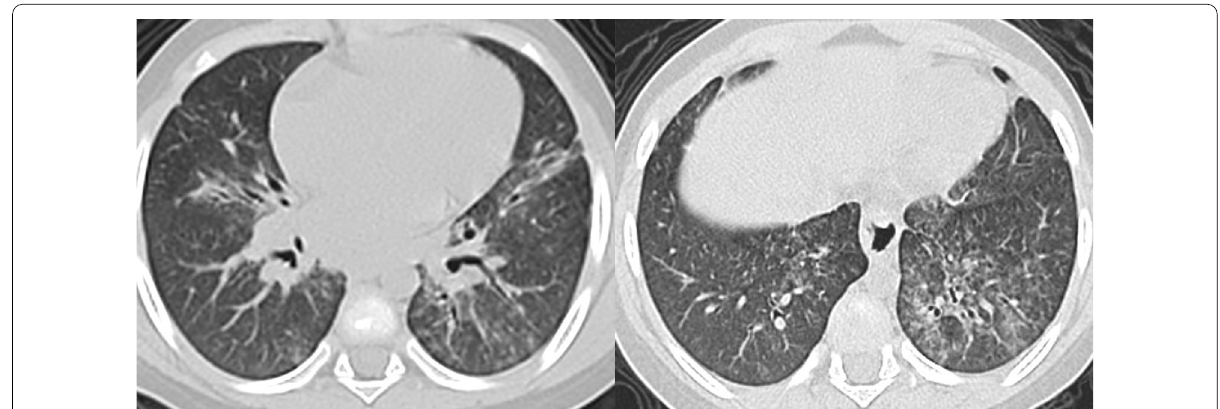
Fig. 4 A 5-year-old male with recurrent chest infection secondary to chronic aspiration showing bilateral bronchial wall thickening mainly in the lower lobes, centrilobular and peribronchial ground-glass densities, and hilar lymphadenopathy, with a CT score of 14